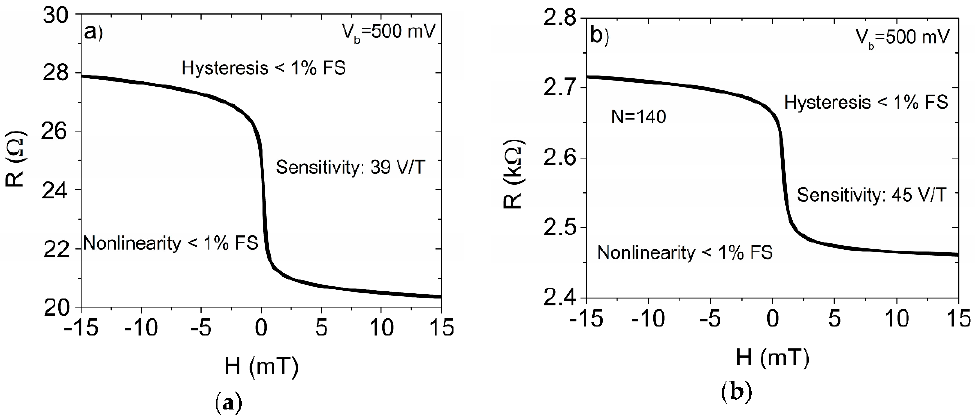
Figure 1. Typical transfer curve of used ( a ) single and ( b ) series-connected sensors (N = 140).